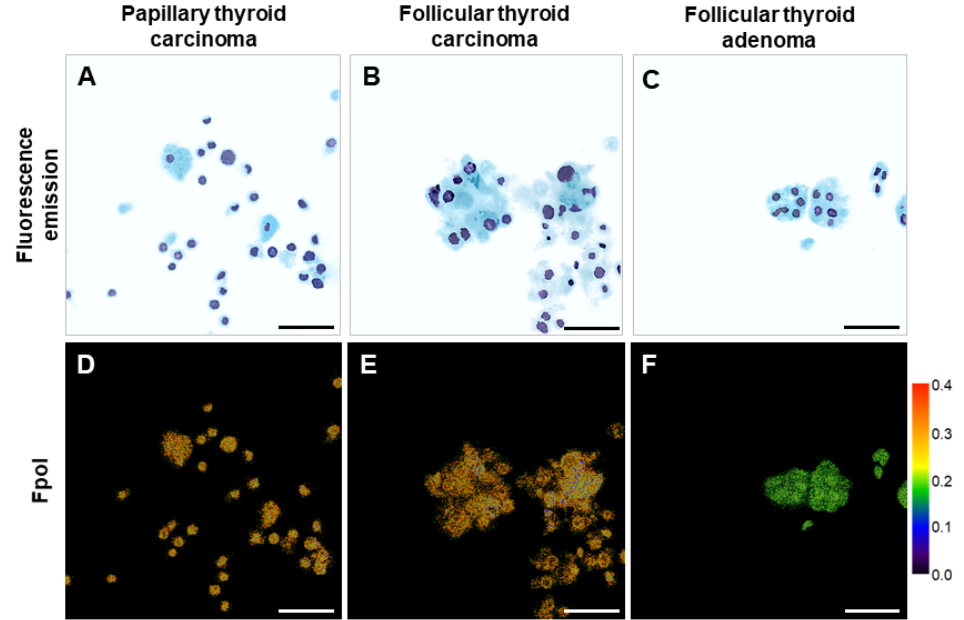
Figure 4. Indeterminate samples. Example MB fluorescence emission images for ( A ) PTC sample (subject 9), ( B ) FTC sample (subject 12), and ( C ) FTA sample (subject 14); ( D – F ) corresponding pseudo-colored MB Fpol images. Scale bar: 50 µm.